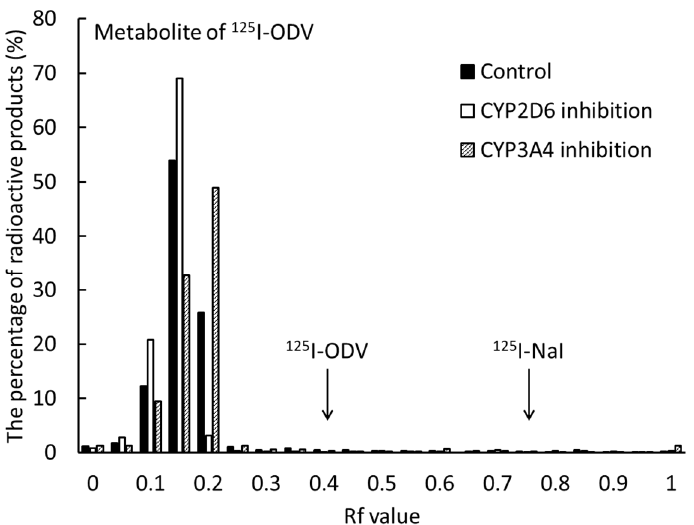
Figure 8. TLC analysis radioactive metabolites in the bile of normal and CYP-inhibited mice after 125 I-ODV injection. The fractions of 125 I-NaI and 125 I-ODV were not found in all conditions, so the metabolite of 125 I-ODV was selectively excreted in the bile.